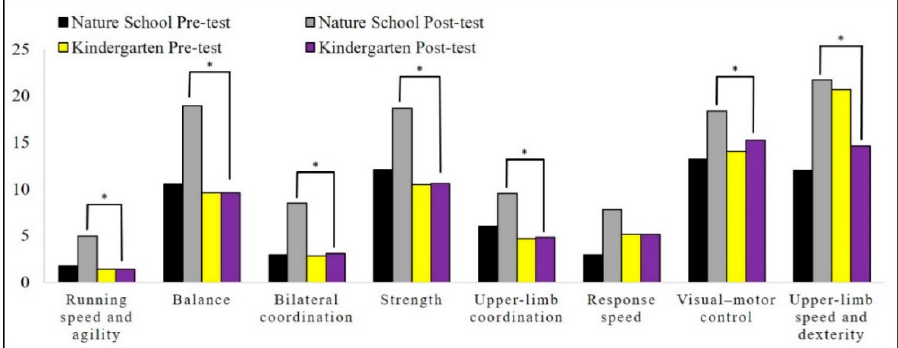
Figure 1. Descriptive statistics of the motor proficiency subscales. * p ≤ 0.05.